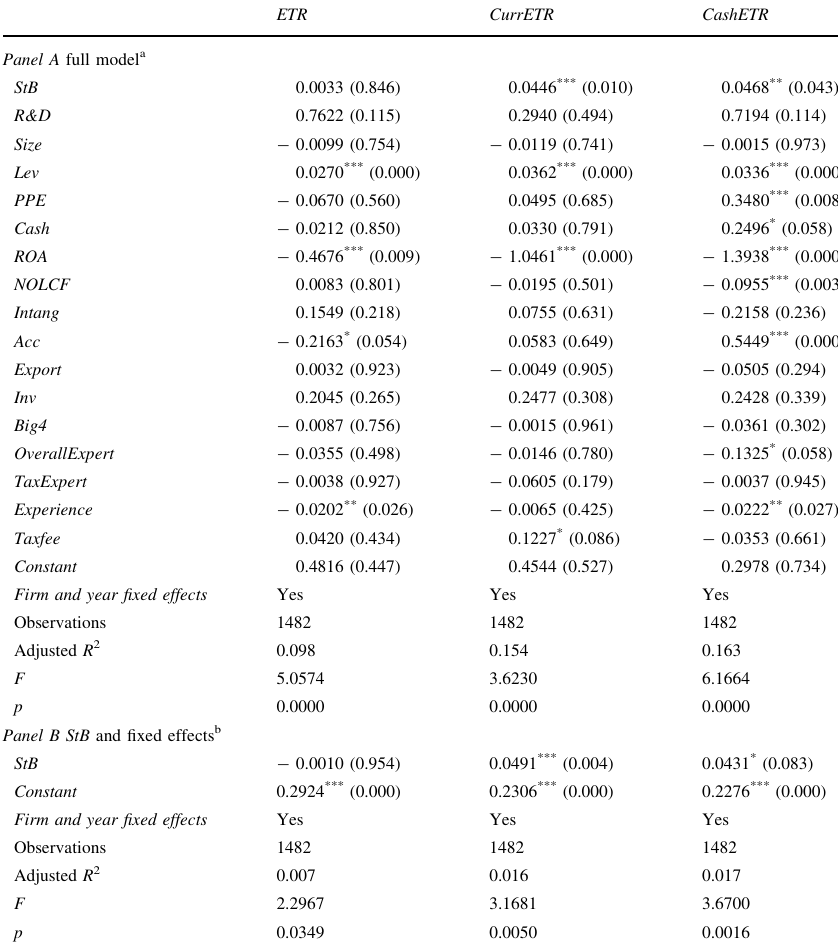
Table 4 Main multivariate